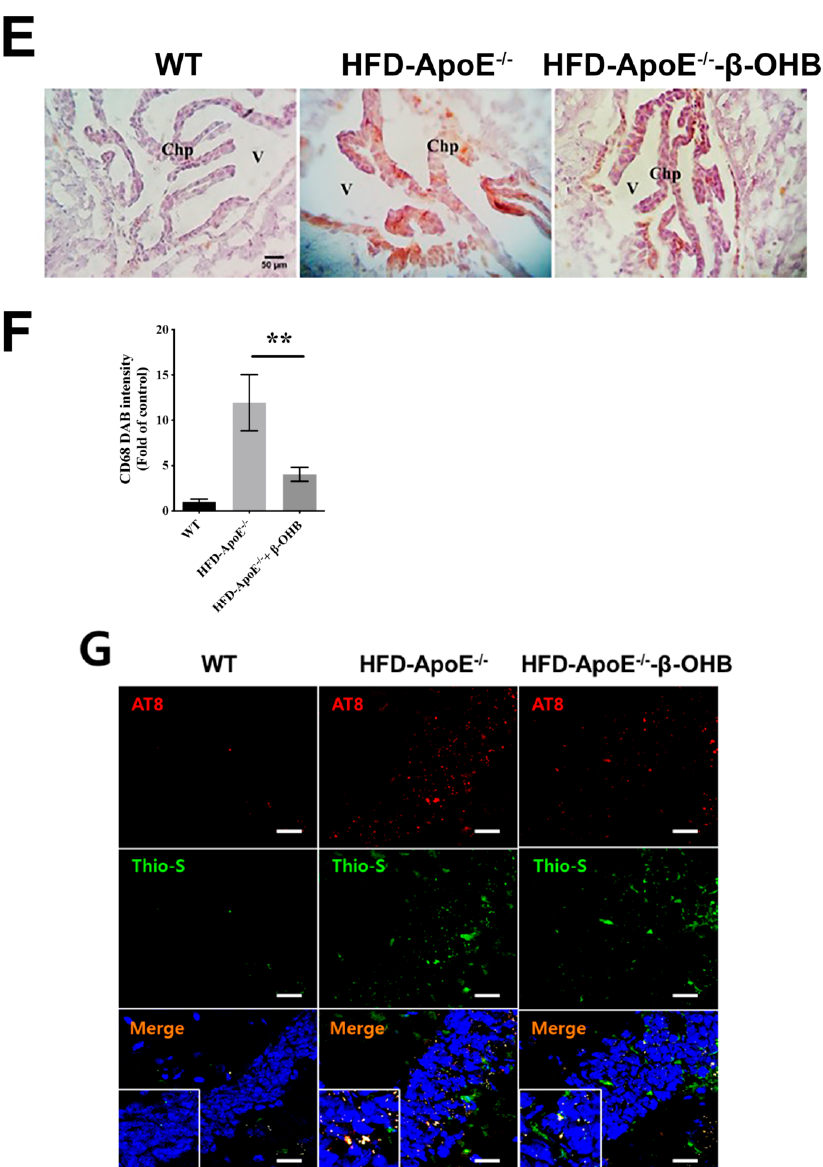
Figure 1. β -hydroxybutyrate ( β -OHB) attenuates apolipoprotein-E (ApoE) − / − -triggered lipid, amyloid deposition and tau accumulation. ( A ). Schematic illustration of the overall in vivo experimental procedure. ( B ) Mice choroid plexus (ChP) sections were stained with oil red O (ORO) for lipid (red, black arrowhead), deposits and counterstained with hematoxylin (HE). ( C ) Quantitative data representations of the percentage of lipid deposit in ChP regions. ( D ) Brain sections were stained with Congo red for amyloid plaque (black arrowhead) deposits and counterstained with HE. ( E ) Brain sections were stained for CD68 + and counterstained with HE. ( F ) Quantitative data representations of the fold increase in CD68 + staining. ( G ) Brain sections were double-labeled with thioflavin-S and AT8 (pSer 202 / Thr 205 ) antibody for tau entanglements (Scale bars = 20 µ m). WT, normal chow diet-fed C57BL / 6J; HFD-ApoE − / − , high fat diet-fed ApoE knock-out; β -OHB, β -hydroxybutyrate; ChP, choroid plexus; V, ventricle; SNR, substantial nigra pars compacta. ** p < 0.001 vs. HFD-ApoE − / − .